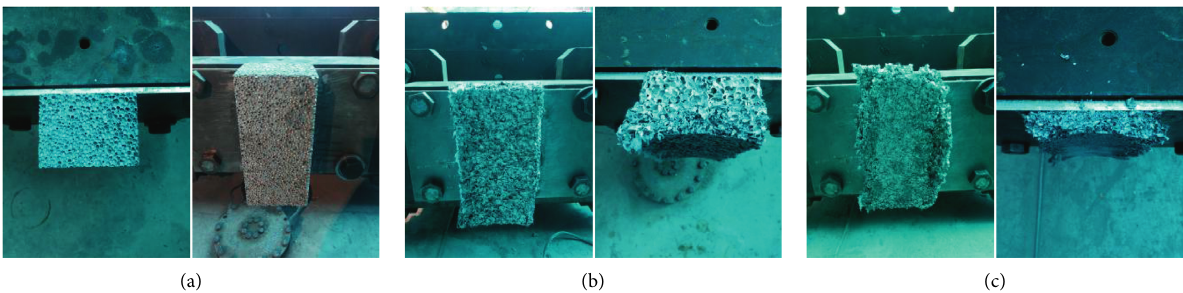
Figure 12: Images of specimen S1-16 closed-cell aluminum foam following impacts. In the figure, the number after specimen S1-16 denotes the lifting height of the drop hammer, unit: m. (a) S1-16-0, (b) S1-16-4, and (c)